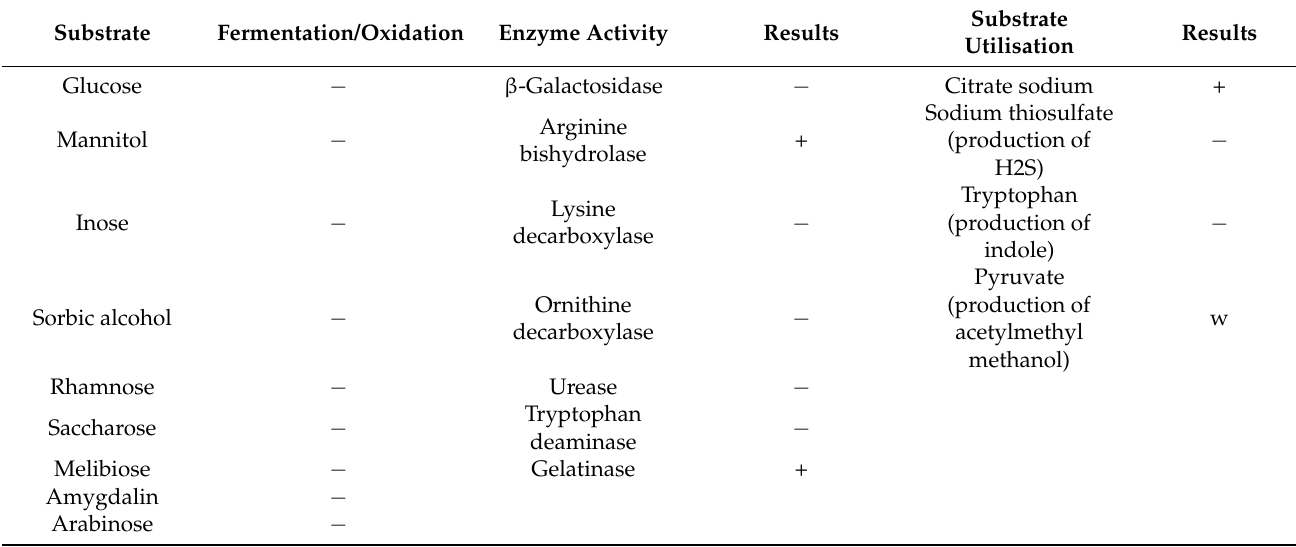
Table A3. Physiological and biochemical characteristics of strain AH7-7 in the API20E identifica- tion system.